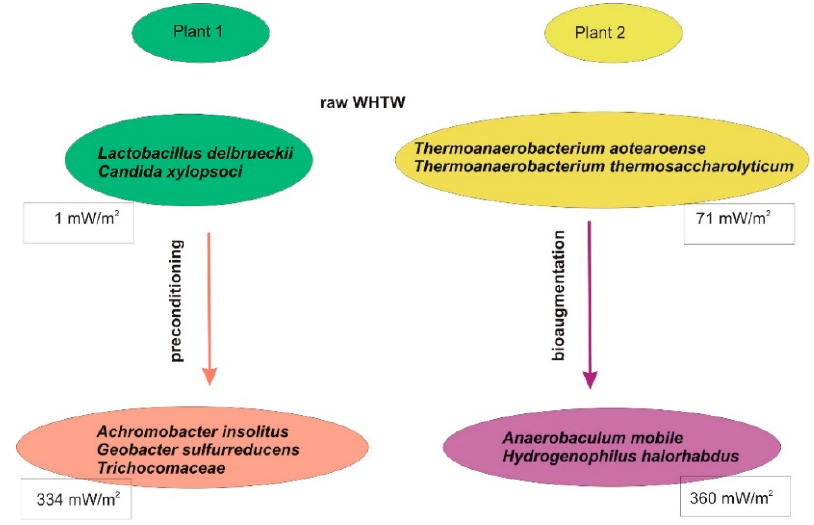
Figure 2. The composition of microbial consortia in WHTW from different plants.